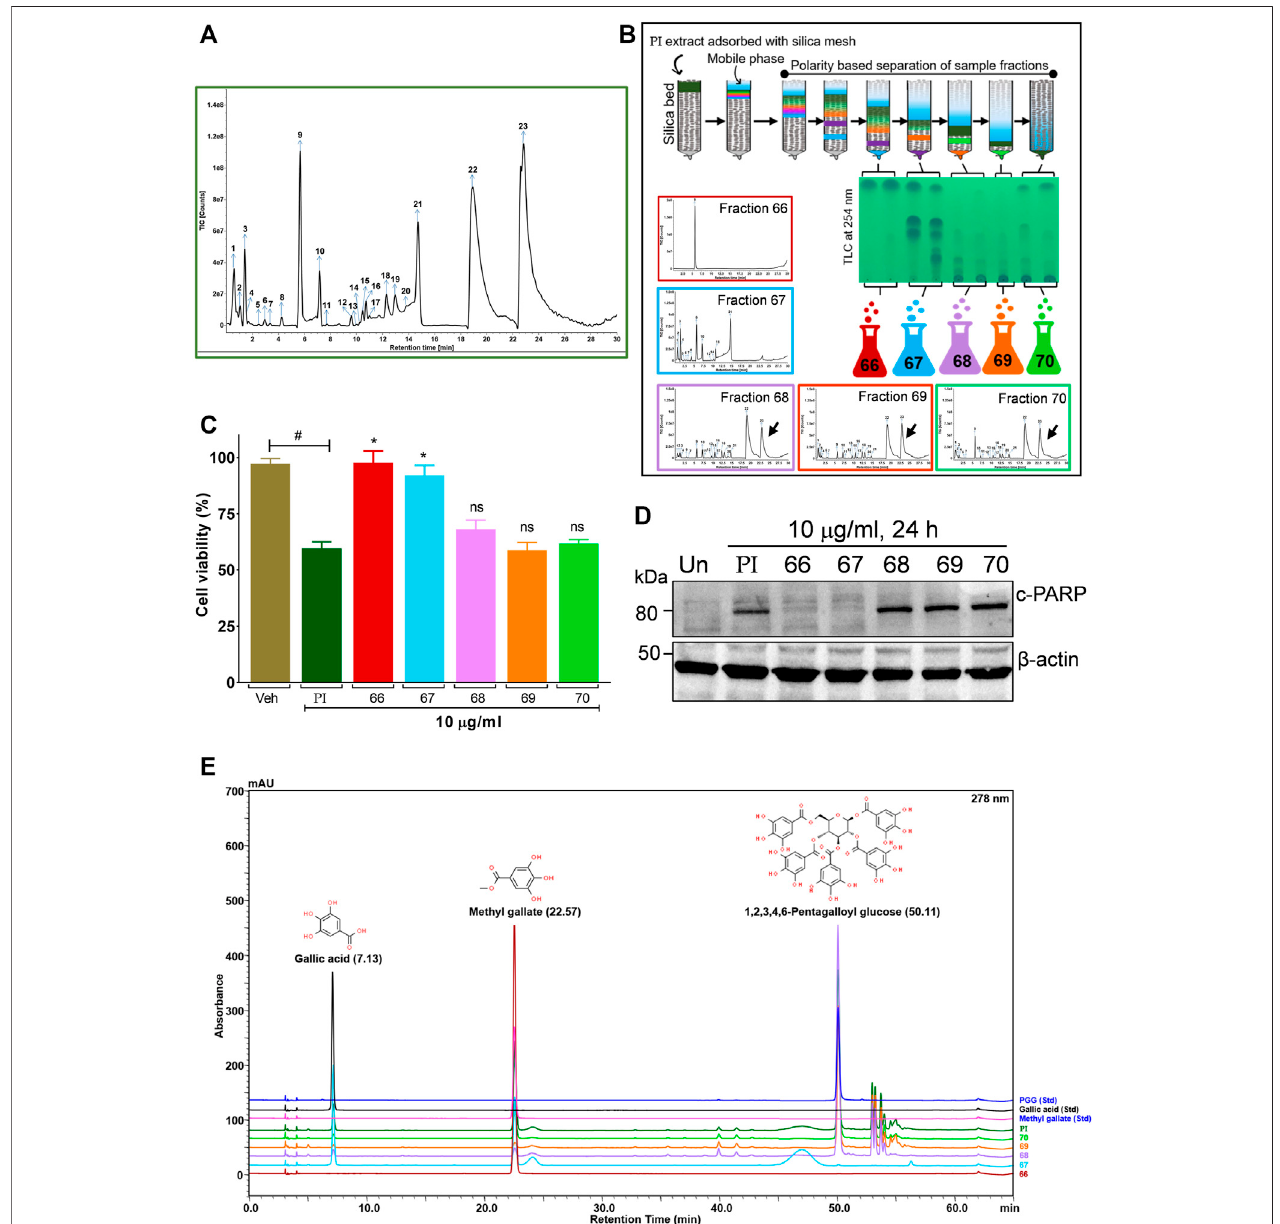
FIGURE 5 | Bioactivity-guided fractionation of Pistacia integerrima identi fi ed penta-O-galloyl- β -D-glucose (PGG) as a bioactive phytocompound . (A) Chromatogramoftotalioncount(TIC)versusretentiontime(min)showspeakslabeledwitharrowsandnumbers.Peaksrepresentingthephytometabolitewereidenti fi ed by UPLC/QToF-MS and detailed in Table 1 . (B) Schematic showing fractionation ofPI extract through column chromatography. A total of 34aliquots were collected as fractions 66,67,68, 69, and 70. UPLC/QToF-MS generated the chromatograms for all the fractions. Peaks 22 and 23 (arrow labeled) corresponding to 1,2,3,4,6- Pentagalloyl Glucose (PGG) and 2-O-digalloyl-1,3,4,6-tetra-O- β -D-galloyl Glucose were not detected in fraction 66 and 67. (C) Percent cell viability was evaluated in A549cellstreatedwithdifferentfractionsat10 μ g/mlfor24 h.Alamarblueassaydeterminedthepercentviabilityinalltreatments( n =4).Signi fi canceinpercentviabilityin all treatments is calculated with respect to PI. Error bars represent mean ± SEM; signi fi cance of data represented as * p < 0.05 and not signi fi cant (ns) if p > 0.05. (D) Whole cell lysates of A549 cells, post 24 h of treatments at 10 μ g/ml, were subjected to Western blotting using antibodies against cleaved PARP1. β -Actin served as a loading control. (E) Overlayed chromatogram generated through UHPLC showing the absorbance and retention time of standards, fractions, and PI.